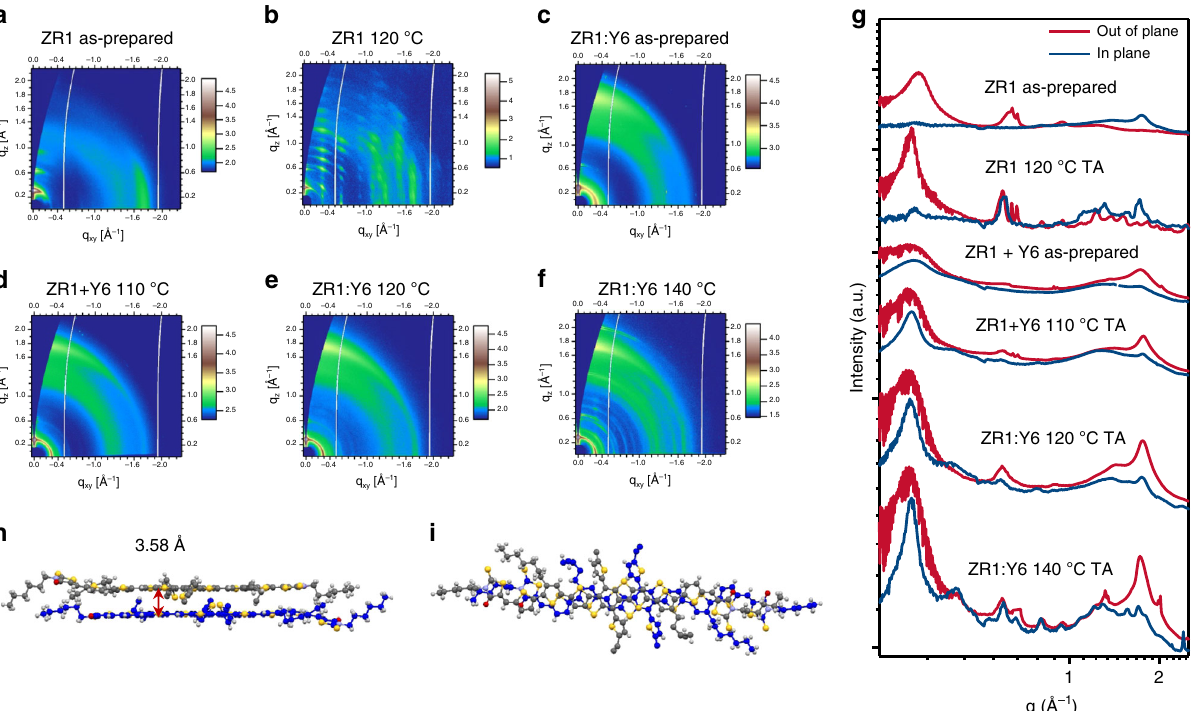
Fig. 2 Microstructures of pristine and blend fi lms. a – f 2D GIWAXS patterns of pristine and blend fi lms. g Corresponding out-of-plane curves and in-plane curves. h View of perpendicular to π -stacking of dimers of ZR1 molecules in its single crystal and ( i ) along the π -stacking